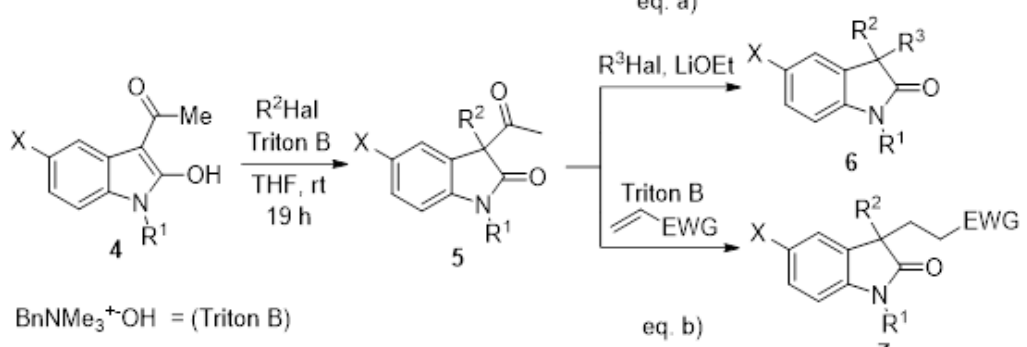
Figure 3 - Synthesis of unsimmetrically 3,3-disubstituted 2-oxindoles by our